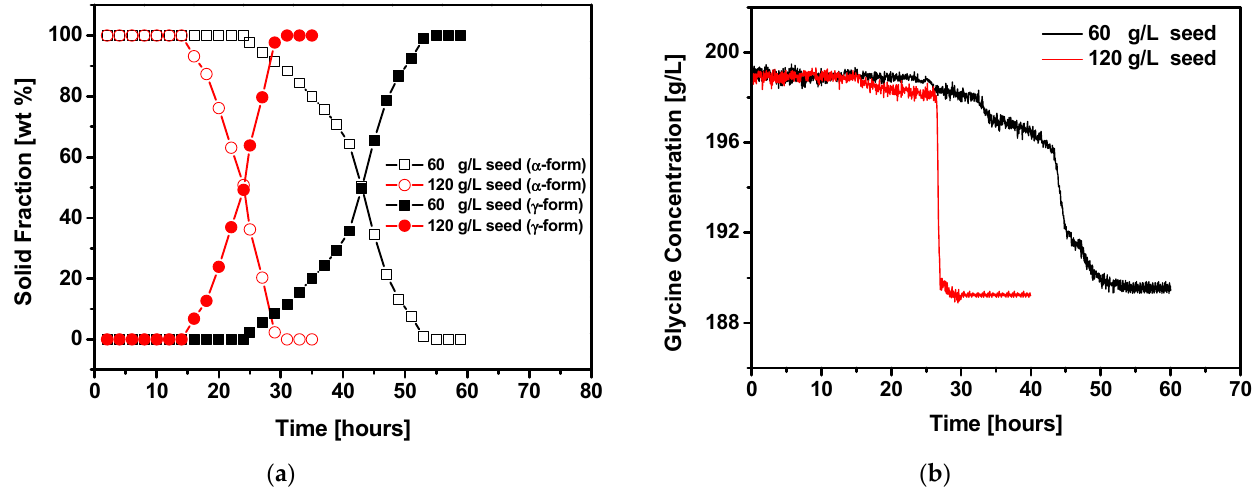
Figure 7. Influence of seed concentrations of α -form on glycine polymorphic phase transformation of α -form to γ -form. ( a ) Solid fraction of γ -form and α -form glycine; ( b ) glycine solution concentration during crystallization. The agitation speed, temperature, and NaCl concentration were fixed at 750 rpm, 20 ° C , and 80 g/L, respectively.